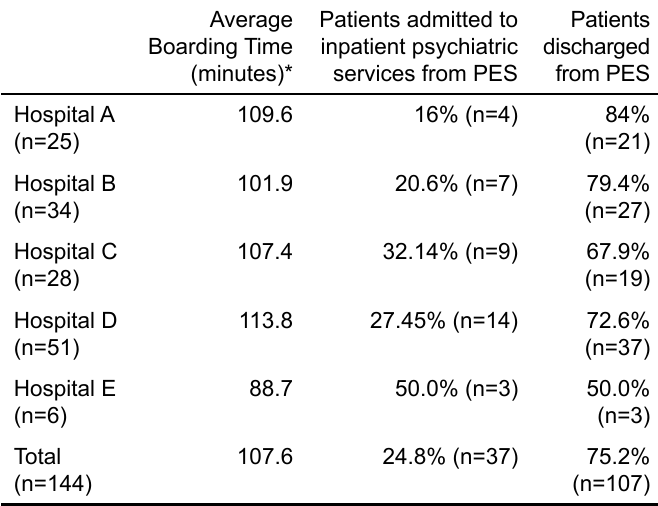
Table 3. Boarding times and disposition, by hospital.